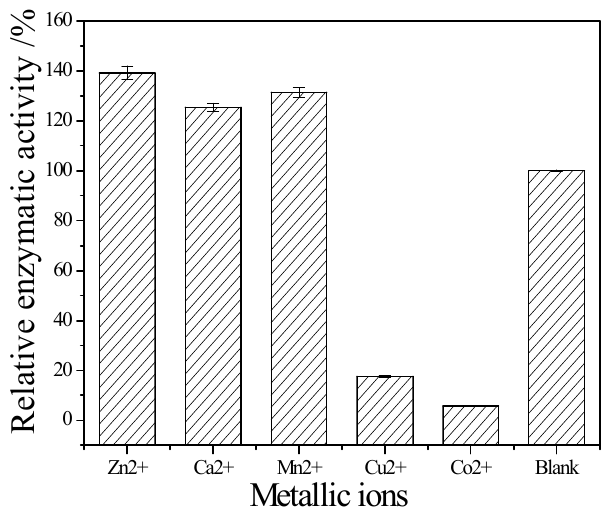
Figure 8. Effects of metal ions on enzymatic activity.